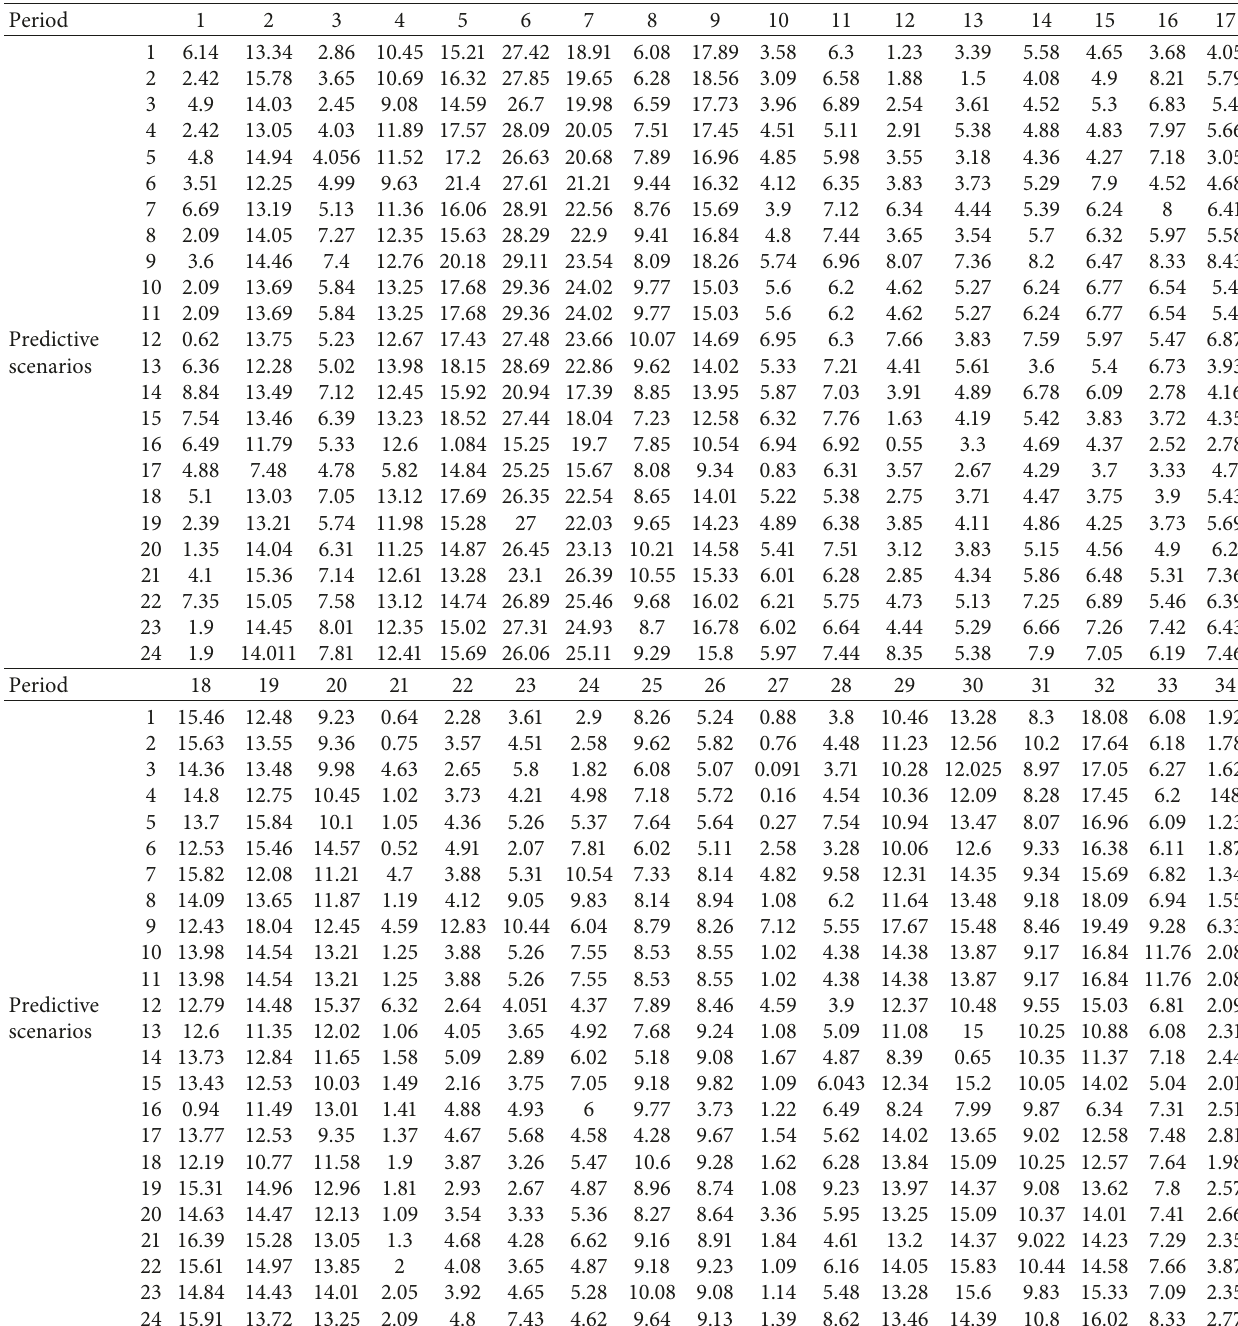
Table 9: Values of bullwhip effect resulting from the